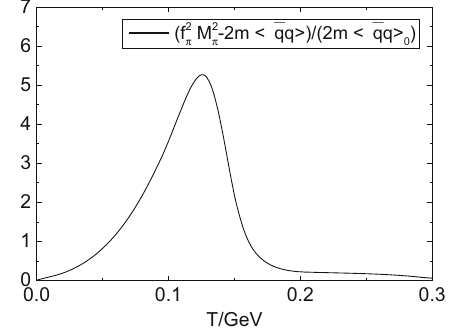
Fig. 5 Deviation of GMOR relation at finite temperature, normalized by the quark condensate product in